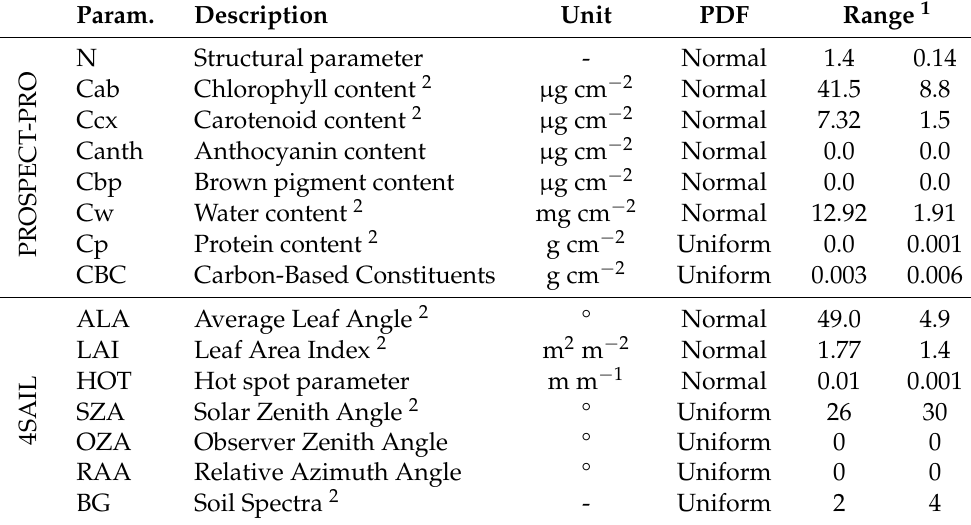
Table 3. List of PROSAIL-PRO input variables used to generate the LUT. Inputs variables were randomly sampled according to the reported distributions and